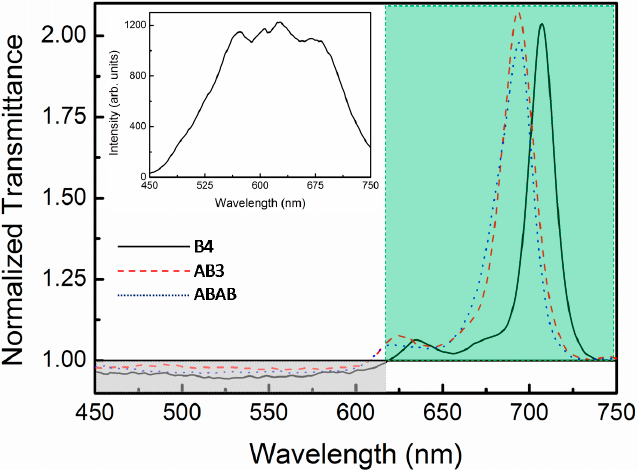
Figure 5. Normalized transmittance spectra obtained by using the white light continuum Z-scan. Each one of the three curves represents the nonlinear transmittance obtained for B4 , AB3 and ABAB dissolved in chloroform. The inset shows the white light continuum spectrum used in the WLCZS Using the normalized transmittance spectra obtained through WLCZS, we were able to calculate the excited state absorption cross-section spectra for all three samples by using Equation (1) and the same rate equation model describe in Equation (2), which also simulates the population fraction as a